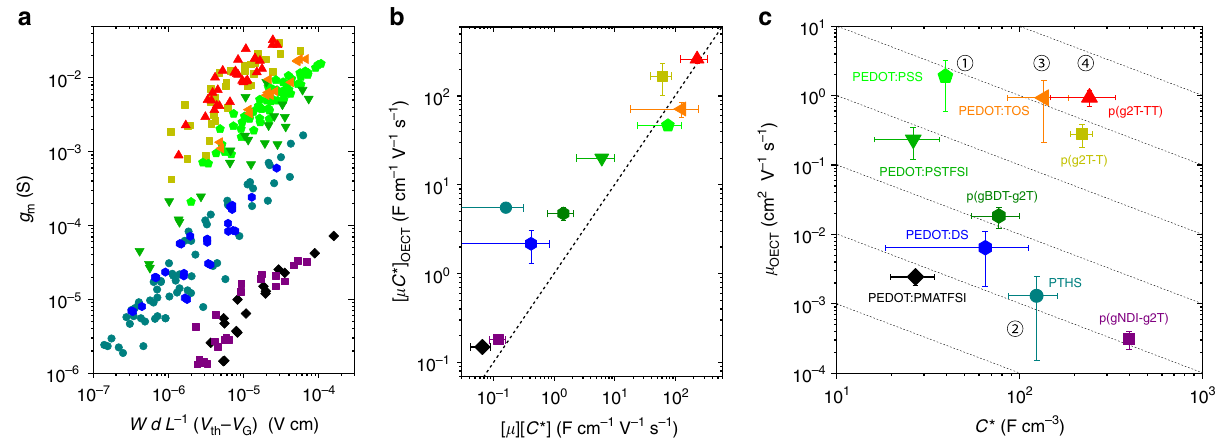
Fig. 2 µ C* as the OECT fi gure of merit. a Transconductance ( g m ) of OECTs as a function operating conditions (in saturation regime) and channel geometry. Each point represents one OECT measurement; each color/shape represent one material, as indicated in the labeling in c . b The linear slope of the data in a , [ µ C* ] OECT , as a function of the product of µ OECT and C* determined independently, [ µ ][ C* ]. The dashed line represents 1:1 agreement between the values. Error bars represent the propogation of errors from the product of µ and C* for which the standard deviation is determined over all devices tested for each material, as well as the error in the linear fi t of data from each material in a . The color coding and shape for each material is as noted in c . c µ OECT − C* map of ten previously reported materials. Dotted lines denote constant µ C* product. Circled numbers in c refer to the discussion in